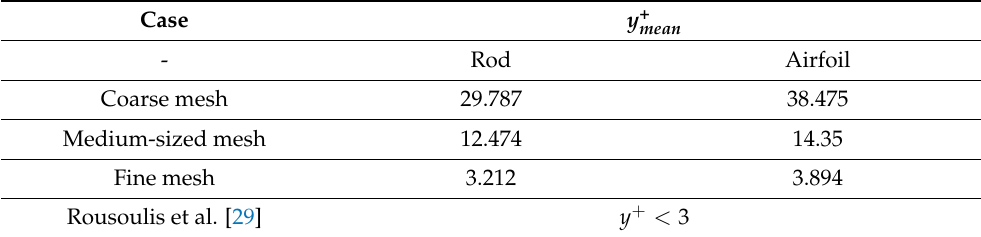
Table 2. Properties of the Computational